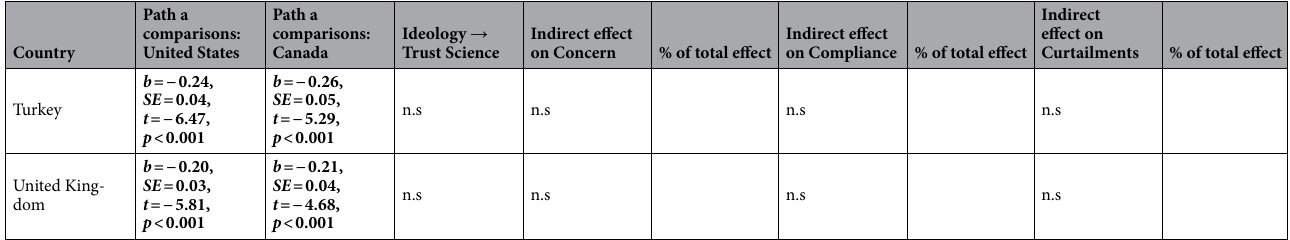
Table 3. Indirect effects of political ideology on each variable, and multigroup comparisons for the association between ideology and trust in science, from Fig. 4. * p < 0.05, ** p < 0.01, *** p < 0.001, n.s. = not significant. The USA and Canada were the reference group in each comparison. Bold values depict significant results. Calculations of the proportion of the total effect calculated by the indirect effect were made by dividing the